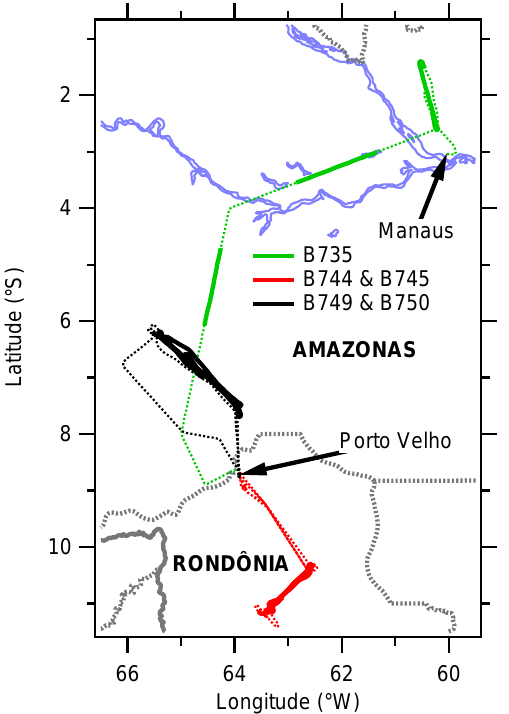
Figure 2. Tracks of the flights presented in this paper. The portions of the flights used in generating the statistics in Tables 1 and 2 (alti- tude below 2km, excluding takeoffs, landings and approaches) are shown as solid lines, with the rest of the flights as